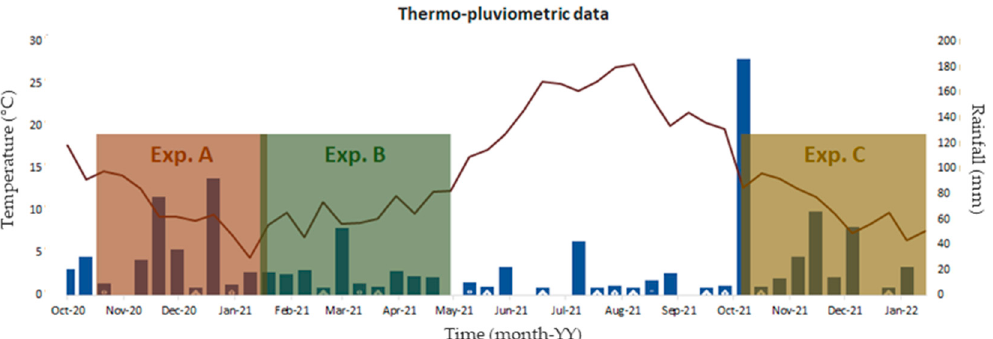
Figure 1. Thermo-pluviometric conditions during Exp. A, B, and C. Brown line represents the 10 days average temperature in degrees Celsius (left Y axis), and blue bars are the total rain registered every 10 days in mm (right Y axis). Semi-transparent boxes cover the time (X axis) from sowing to harvesting for each experiment: red, green, and yellow for Exp. A, B, and C, respectively.